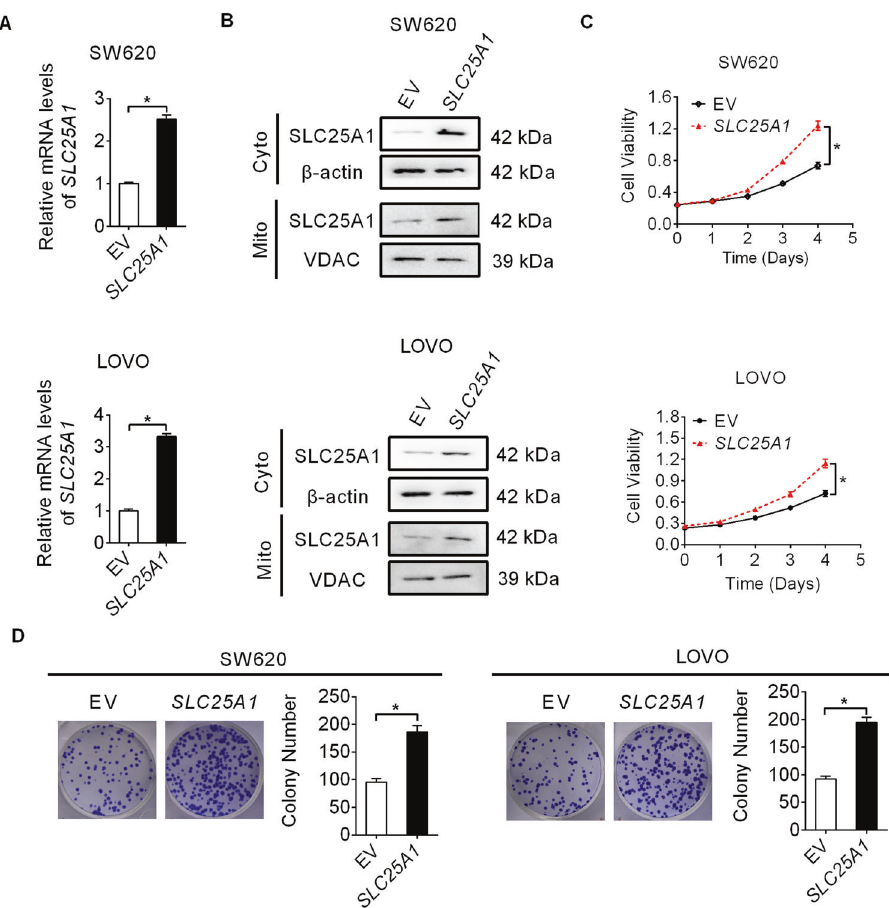
Fig. 3 SLC25A1 overexpression promotes CRC cell growth. A , B Over-expression of SLC25A1 was con fi rmed by qRT-PCR and western blot analysis in SW620 and LOVO cells (Mito mitochondria, Cyto cytoplasm). C Cell proliferation was determined by MTS assay in SW620 and LOVO cells with SLC25A1 overexpression. D Colony formation assay in SW620 and LOVO cells with SLC25A1